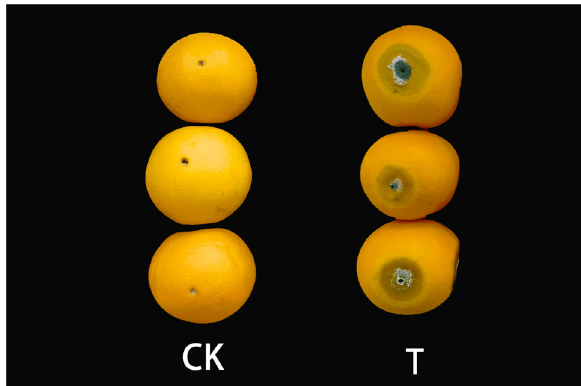
Figure 1. Sweet oranges infected with P. digitatum and controls. CK, control fruits; T, fruits infected with P. digitatum .